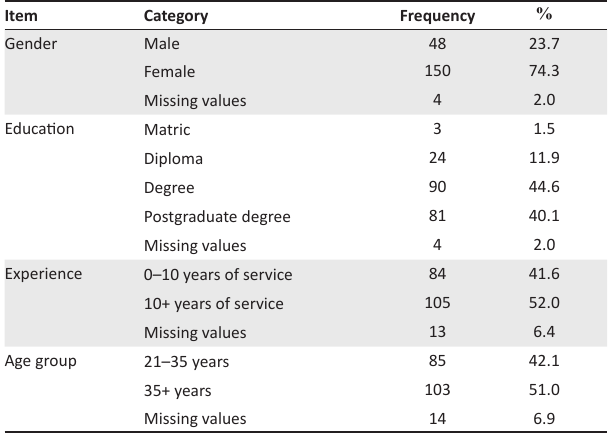
TABLE 1: Characteristics of participants ( N =